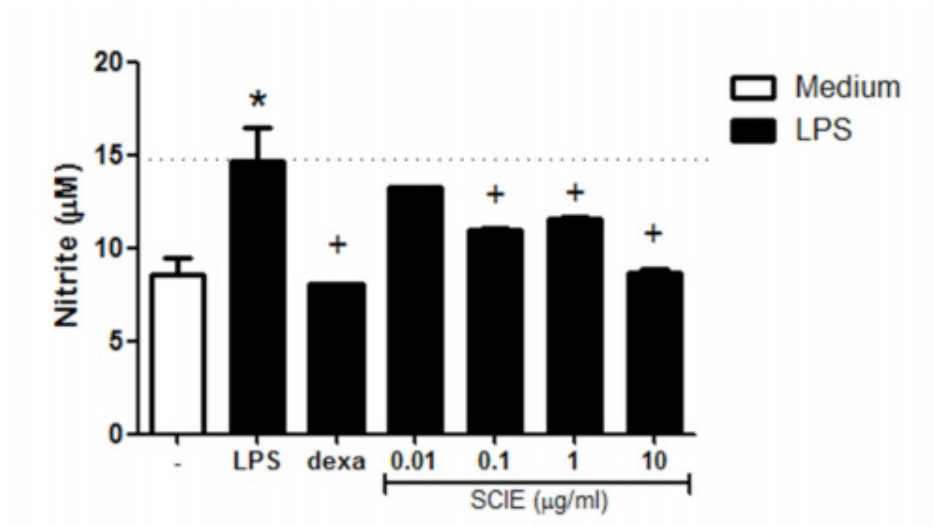
FIGURE 1 - Production of nitric oxide (NO) in J774A.1 cells treated with different concentrations of SCIE. The NO production was determined by the Griess reagent through the supernatant collected 24 h after the LPS simulation. The results were expressed as mean ± standard error of the mean (SEM). * indicates statistically significant difference (p < 0.05) between stimulated group (LPS) and non-stimulated group (Medium); + indicates statistically significant difference between treated and untreated stimulated group